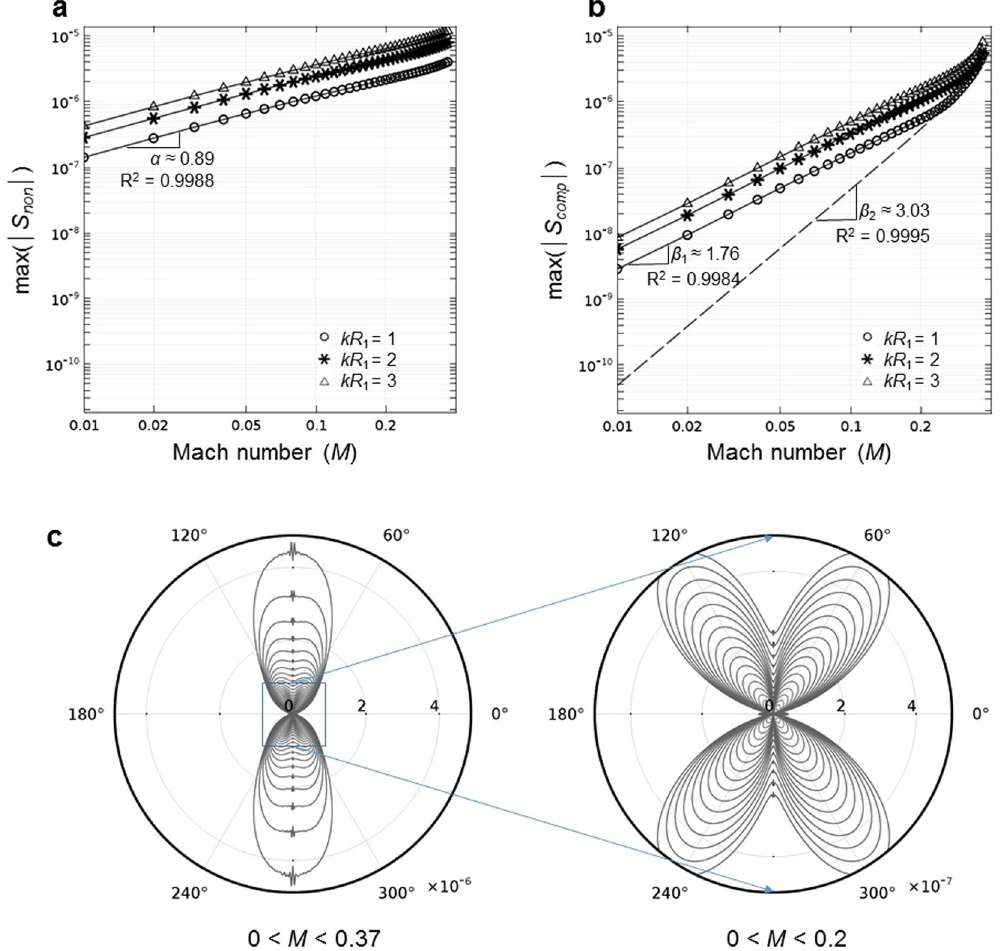
Figure 6. Parametric study on velocity law of the magnitude in compressibility and non-uniformity source terms. ( a ) The log-log plot of maximum magnitude of non-uniformity source term S non versus Mach number for kR 1 = 1, 2, 3. ( b ) The log-log plot of maximal magnitude of compressibility source term S comp versus Mach number for kR 1 = 1, 2, 3. ( c ) The directivity plots of compressibility source term S comp along the surface of acoustic cloak for kR 1 = 1 and various Mach numbers. In all figures, the Mach number is changing from 0.01 to 0.37. In ( b ), symbols (circles, asterisks, and triangles) indicate the maxima of compressibility source terms for kR 1 = 1, 2, 3, respectively. The dashed line indicates maximum values of dipole strength. In ( c ), whereas the left panel shows the directivity plot for all Mach numbers from 0.01 to 0.37, the right panel shows the enlarged directivity plot for relatively low Mach numbers from 0.01 to 0.2 in order to observe the transition of polarity type from quadrupole to dipole as the Mach number